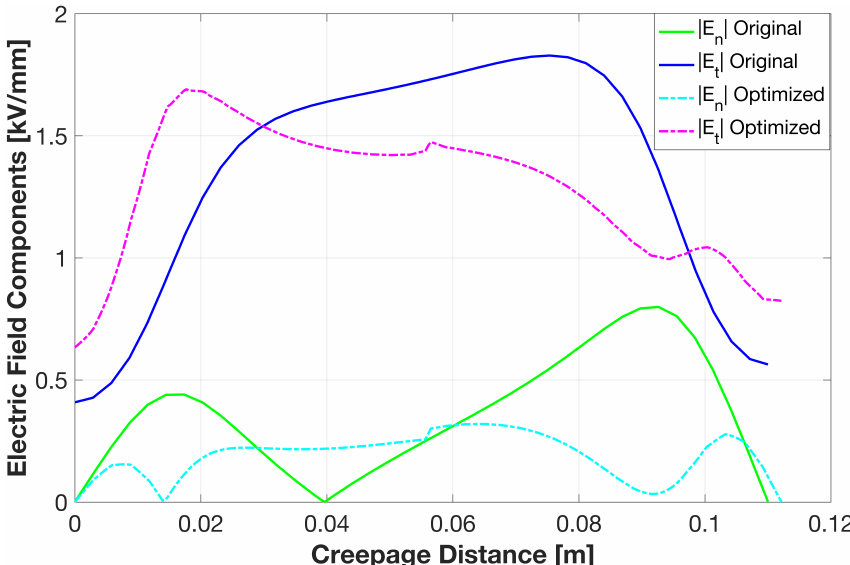
Figure 12. Electric field components |E n | and |E t | on the insulator surface for the reference and optimized